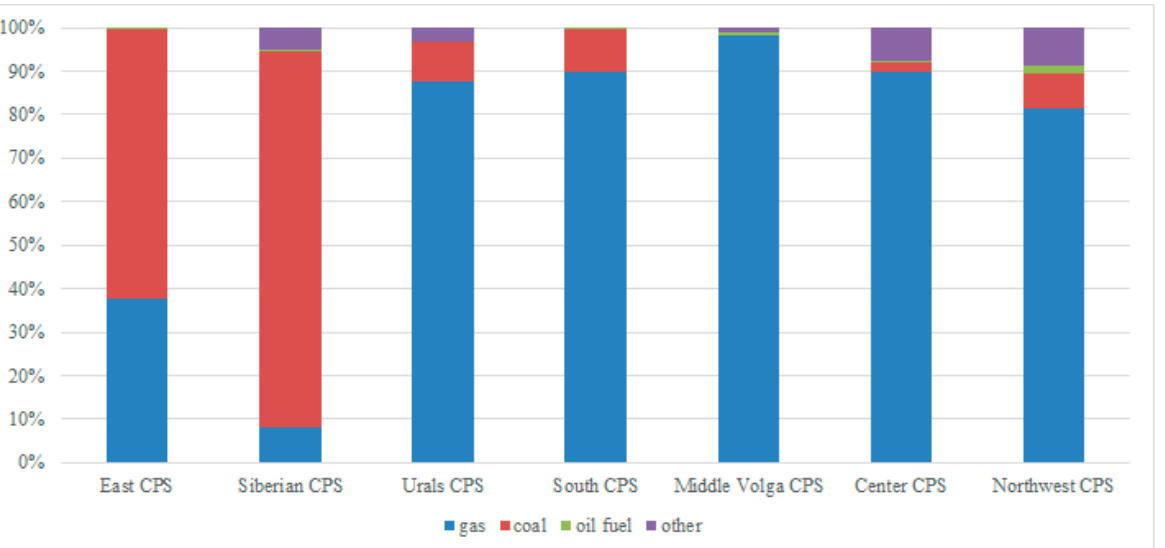
Figure 3. The structure of the installed capacity of power plants in the CPSs of Russia: HPP—hydro- Figure 3. electric power station; NPP—nuclear power plant; WPP—wind power station; SPP—solar power plant; TPP—thermal power plant; CCGT—combined-cycle gas plant; GTP—gas turbine plant; SPP—steam power plant (Source: Report on the functioning of the UES of Russia in 2020).